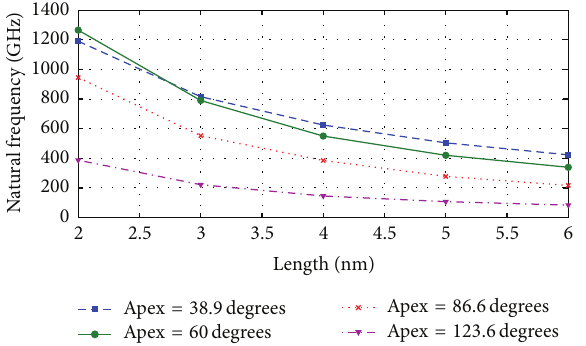
Figure 6: Variation of natural frequencies of the SWCNCs versus the length for different apex